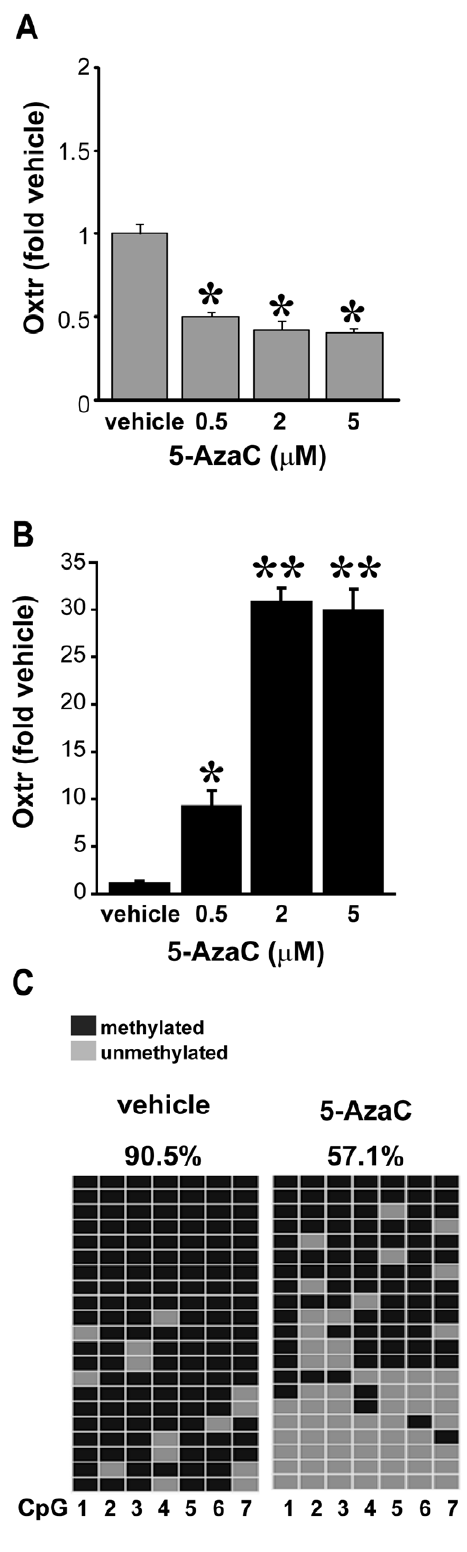
Figure 3. Demethylation induces Oxtr expression in 4T1 cells. A ) In GT1-7 cells, which normally show high Oxtr mRNA levels and low methylation, A two-day treatment with 5-AzaC caused a slight reduction in Oxtr mRNA levels B )Conversely, treatment of 4T1 cells with 5-AzaC caused a robust dose-dependent increase in Oxtr mRNA levels.. C ) 5-AzaC treatment (2 m M) of 4T1 cells caused a